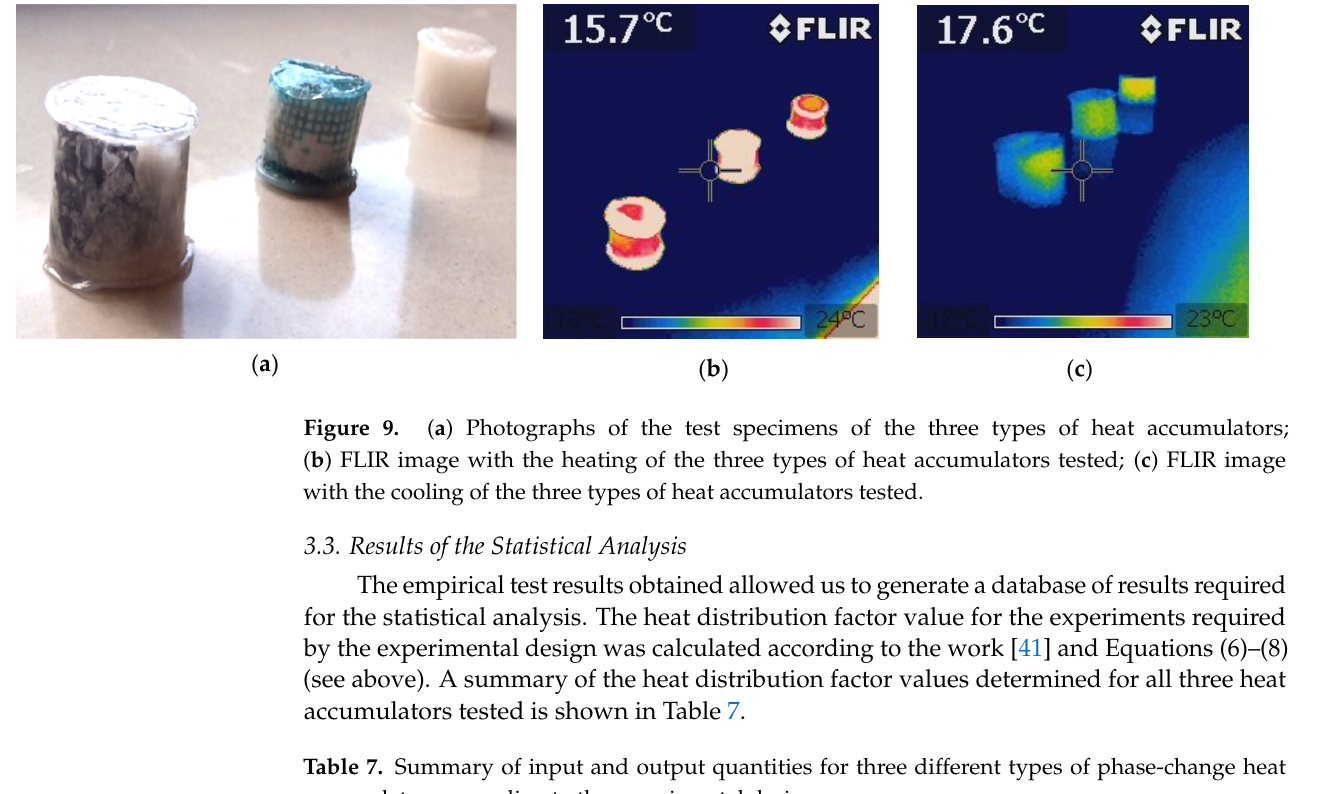
Table 7. Summary of input and output quantities for three different types of phase-change heat accumulators, according to the experimental design.